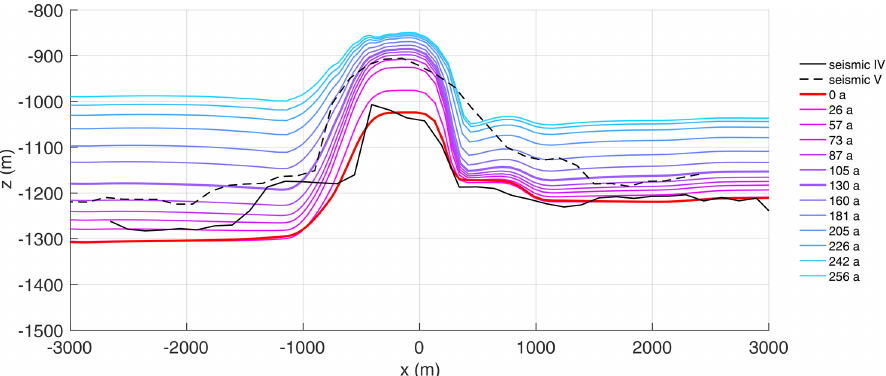
Figure B5. Evolution of the base for the second experiment applying synthetic melt rates in the viscoelastic simulation. The black curve shows seismic profile IV (Hofstede et al., 2021b), and the red line is the simulated base after the spin-up. For each position of pRES observations, the simulated base is shown using a color distribution ranging from red (furthest upstream) to blue (furthest downstream). The dashed black line is the base of seismic profile V (Hofstede et al., 2021b) near the pRES observation fitting to 130 years. The opening of the basal channel cannot be rebuilt with the model as the melt rate inside the channel is only applied to constant channel width. The basal channel stays open during the simulation time of 256 years.